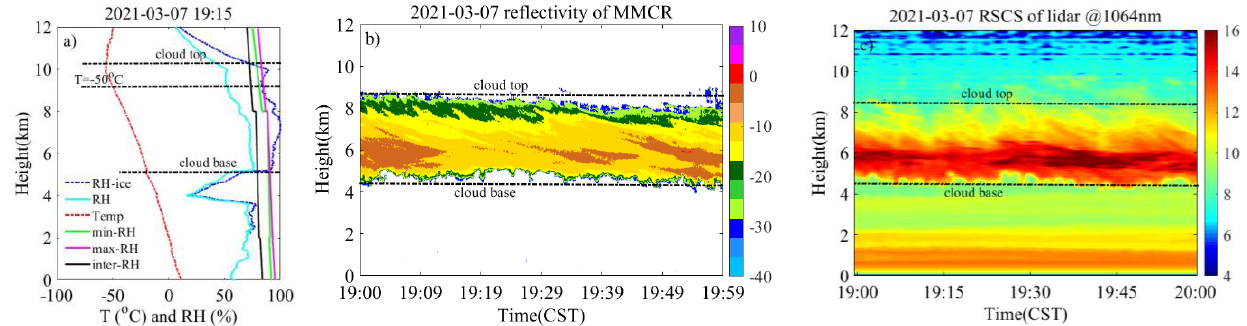
Figure A1. Cloud information observed by the radiosonde, MMCR, and lidar on 7 March 2021. ( a ) Temperature and RH obtained by the radiosonde, ( b ) reflectivity factor observed by the MMCR, and ( c ) 1064 nm signal of the lidar.